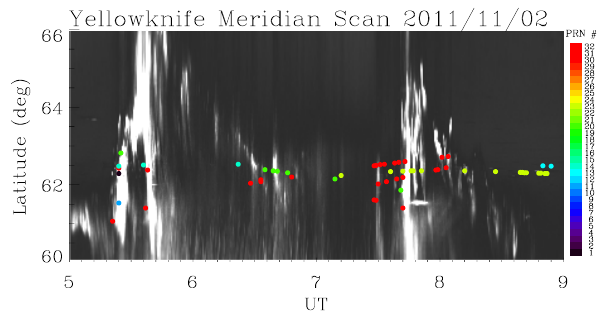
Fig. 8. The meridian scan of auroral intensity as a function of geo- graphic latitude and UT assuming the mapping altitude of 110km. The IPPs for elevation angles above 30 ◦ and DPR exceeding 4mms − 1 are